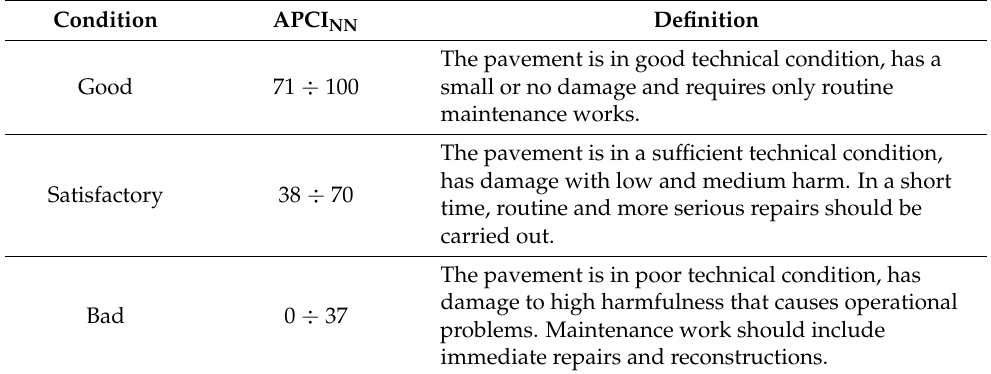
Table 5. Criteria for assessing the technical condition of the natural pavement of airfield functional element.